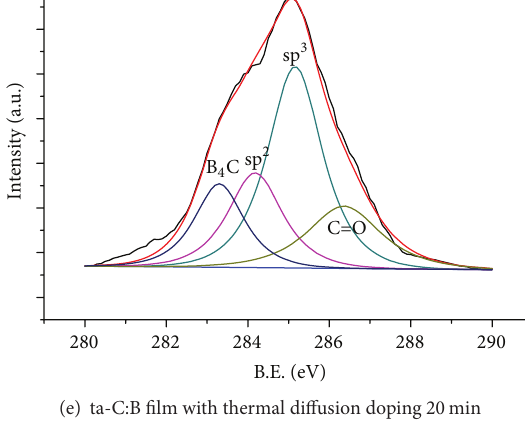
resistivity exhibits evident reduction, to about 350 Ω⋅